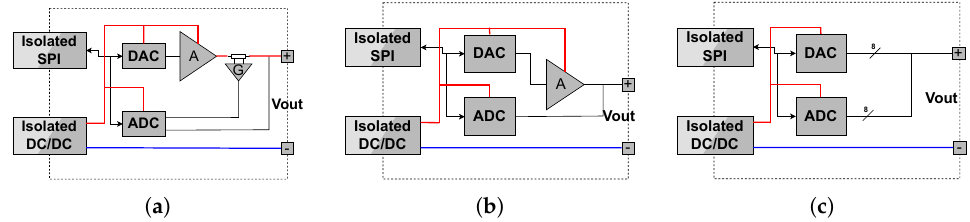
Figure 3. Architecture of cell voltage emulator ( a ); current sensor emulator ( b ); temperature sensor emulator ( c